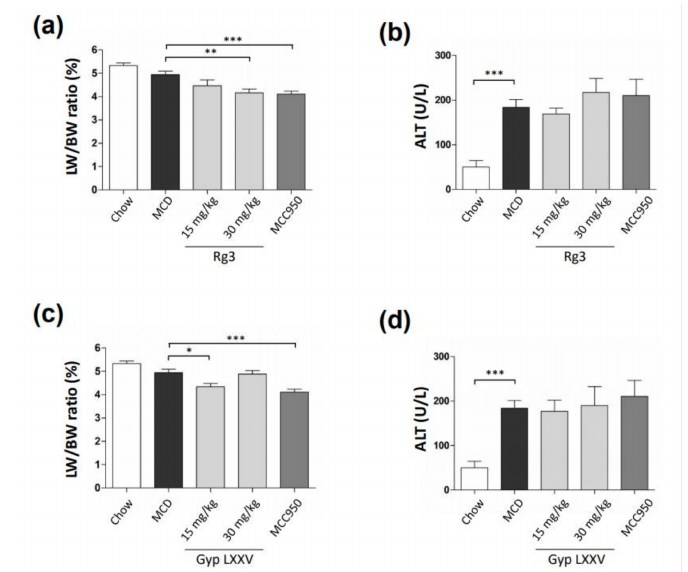
Figure 3. E ff ect of Rg3 ( a , b ) or Gyp LXXV ( c , d ) on the liver-to-body weight ratios (LW / BW ratio) and serum enzyme levels (ALT) in the MCD diet mouse model. Error bars represent SEM. * p < 0.05, ** p <